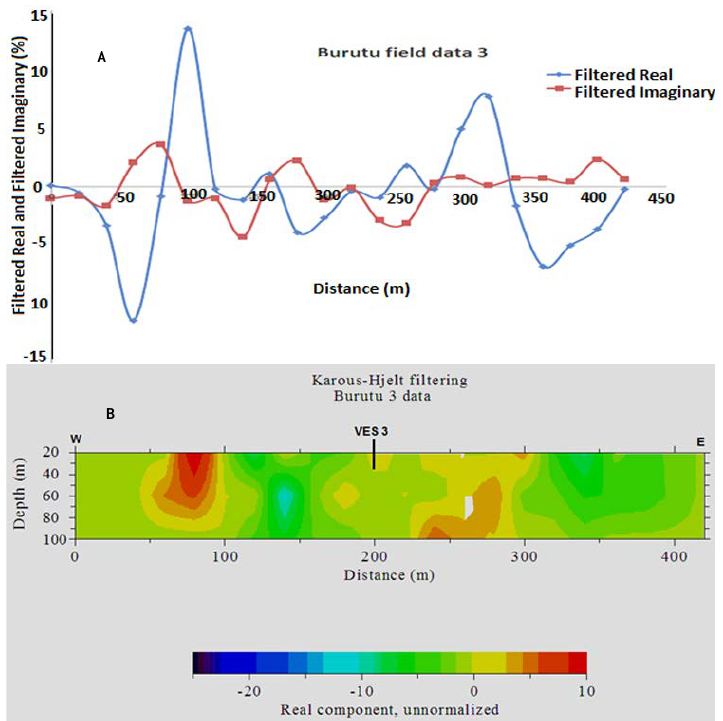
Figure 4. Plot of filtered Real and Imaginary components ( A ) and current density pseudo-section ( B ) for VLF Profile 3.